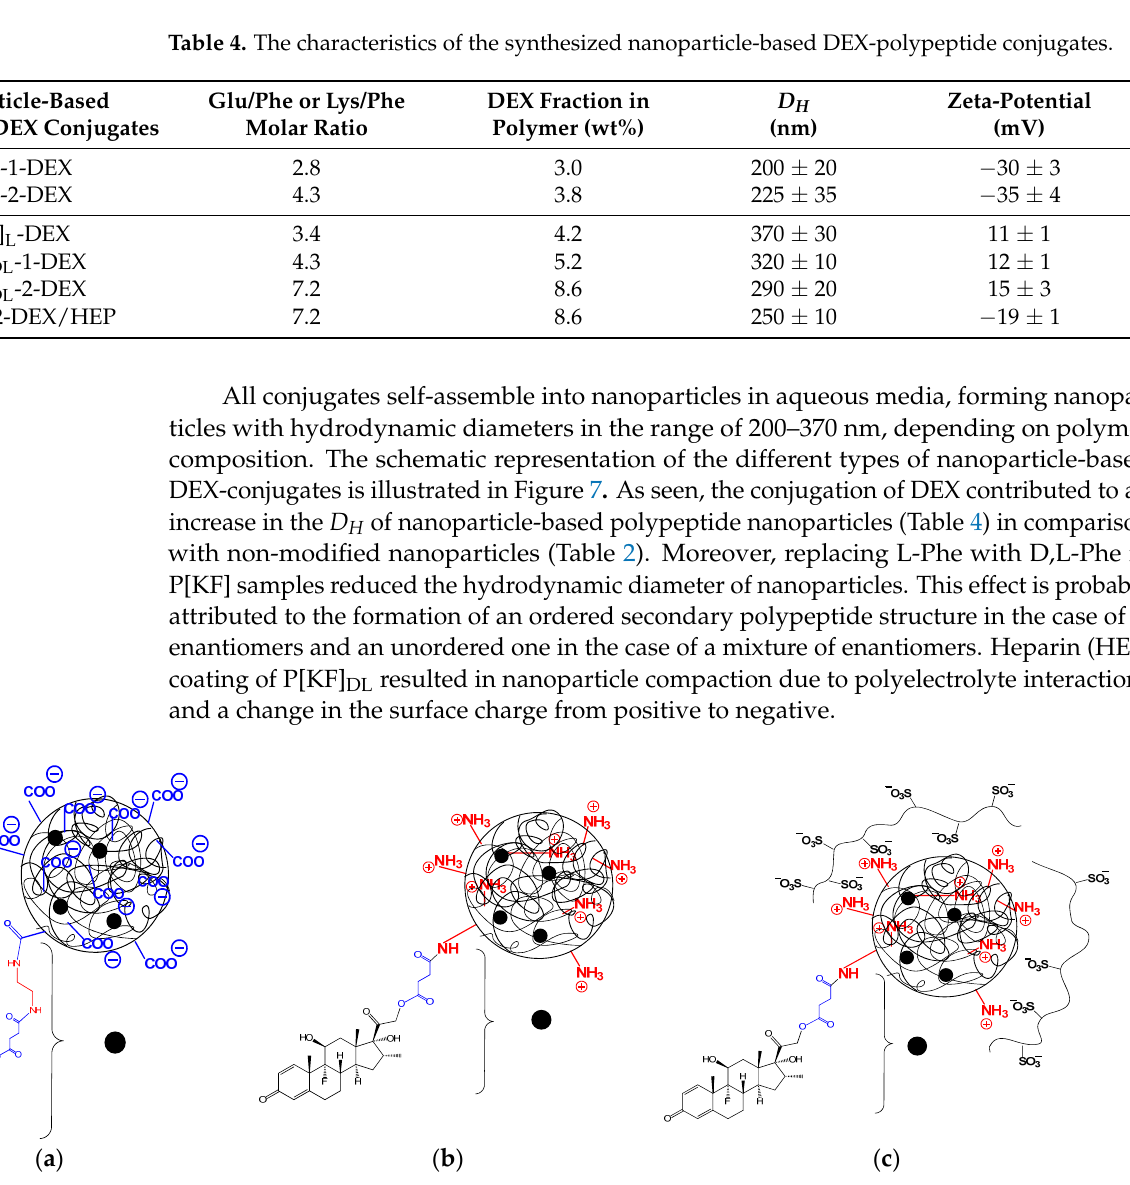
Figure 7. Schematic representation of the different types of self-assembled nanoparticle-based DEX- conjugates: P[EF] − DEX ( a ), P[KF] − DEX ( b ) and P[KF] − DEX/HEP ( c ).